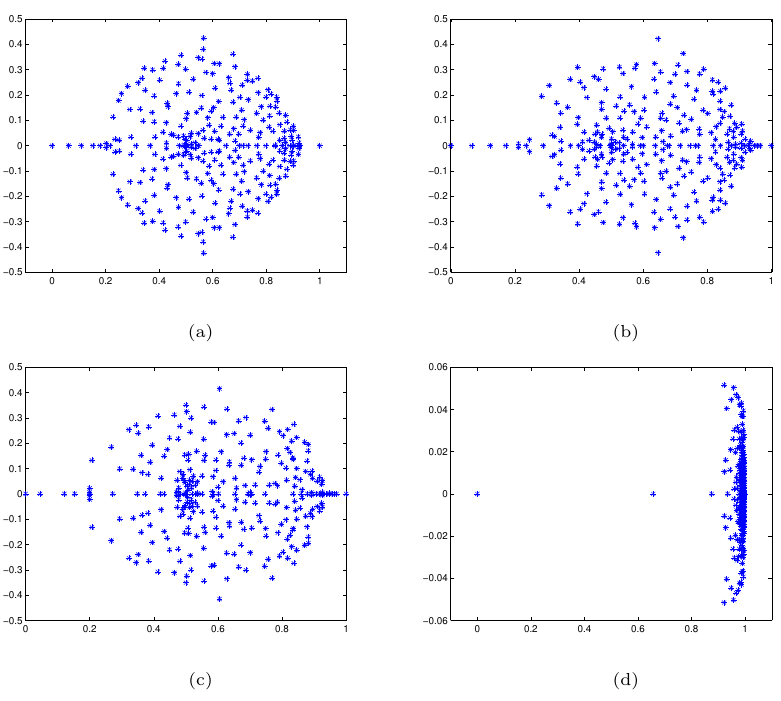
Figure 2. Spectrum of the preconditioned steady Oseen matrix, Q2-Q1 FEM, 32 × 32 uniform grid, ν = 0 . 001, and experimentally optimal τ,α,γ . (a): the RDF, (b): the SPP, (c): the MAL, (d): the